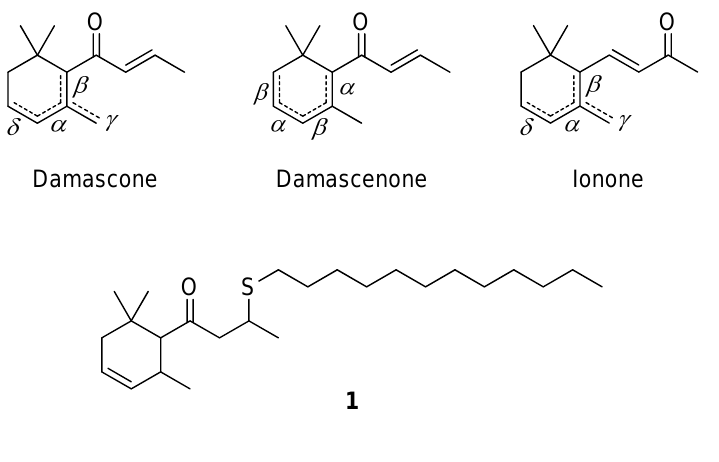
Figure 1. Structures of volatile damascones, damascenones and ionones (the suffixes α -, β -, γ - or δ - designate the location of the double bond(s)) and commercially available profragrance 1